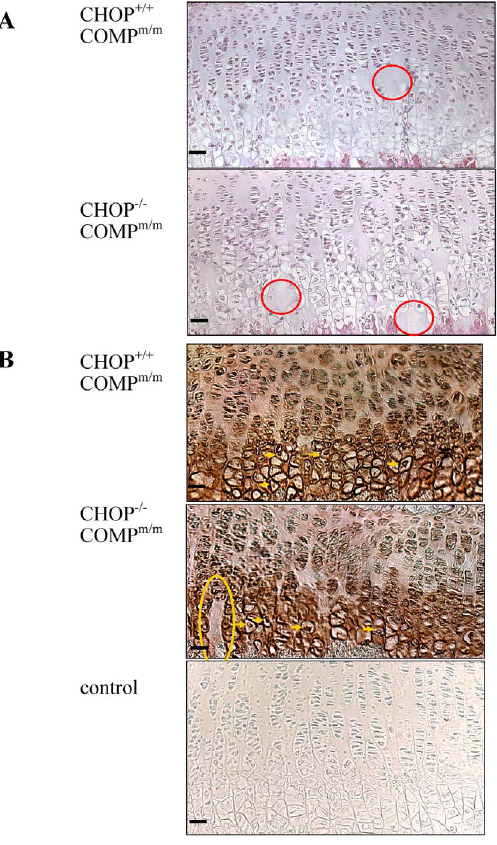
Figure 5. Histochemical and immunohistochemical analysis of growth plate cartilage. A ) Haematoxylin and eosin staining of T585M COMP mutant and either CHOP wild type [CHOP + / + COMP m/m ] or CHOP null [CHOP 2 / 2 COMP m/m ] growth plates at 3 weeks of age. Areas of hypocellularity localised to the lower hypertrophic zone (red circles) are seen in [CHOP 2 / 2 COMP m/m ] cartilage compared to [CHOP + / + COMP m/m ] controls. B ) Immunohistochemistry for COMP showing abnormal columnar organisation of the growth plate in the COMP mutant CHOP null mice [CHOP 2 / 2 COMP m/m ] with areas of hypocellularity (yellow circles) in the hypertrophic zone at 3 weeks of age. Mutant COMP was also retained in chondrocytes of the hypertrophic zone of both [CHOP + / + COMP m/m ] and [CHOP 2 / 2 COMP m/m ] due to the enriched C57BL6/J background in this model (see yellow arrows). Positive staining for COMP is brown with a green nuclear counterstain. The negative control was generated using a secondary antibody only. Key: CHOP + / + COMP m/m =CHOP wild type and T585M COMP mutation (homozygous); CHOP 2 / 2 COMP m/m =CHOP null and T585M COMP mutation (homozygous). Scale bar in all images is 100 m